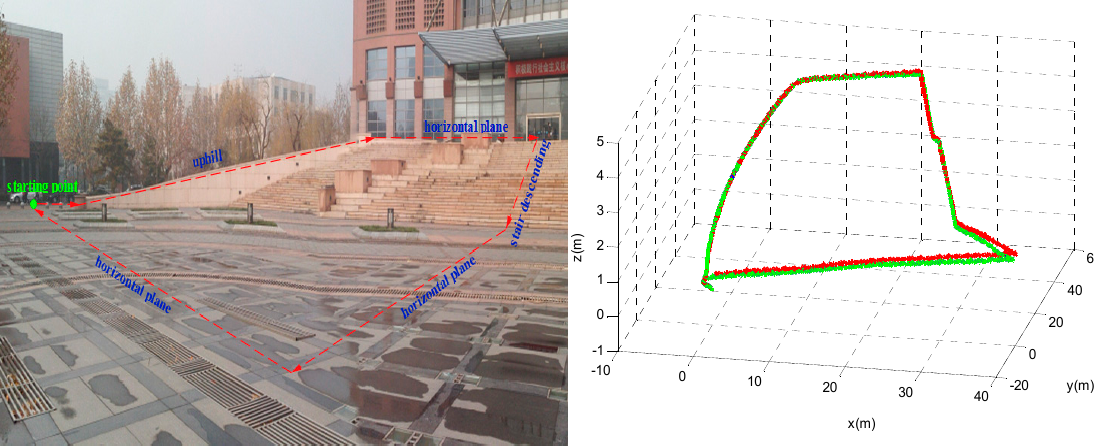
Figure 12. Uphill and stair descending trajectory. Path used for testing ( left ). The calculated trajectories of the proposed algorithm ( right ).